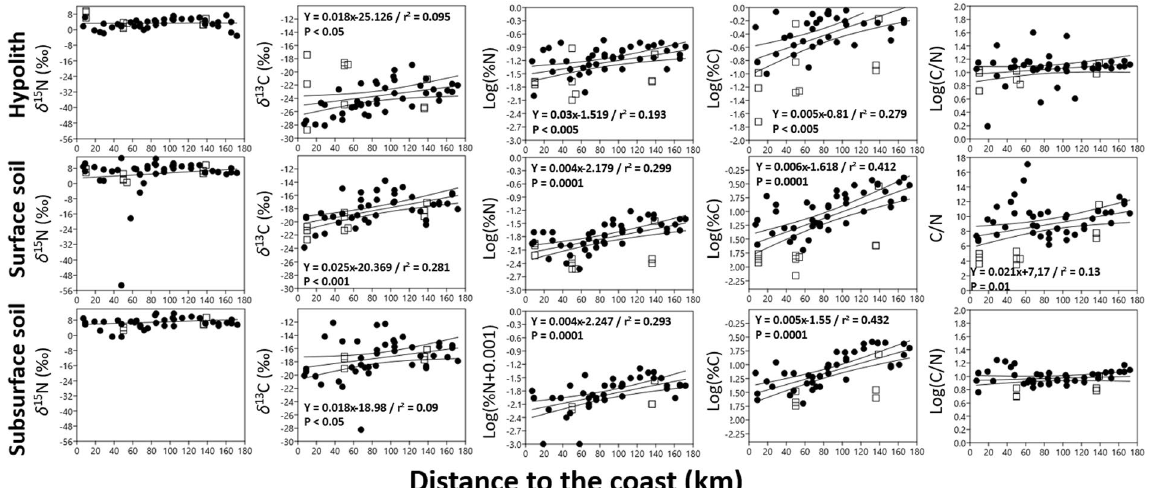
Figure 4. Spatial relationships between Namib Desert hypolithic and edaphic C and N chemistries with the distance to the coast. When significant (p < 0.05) relationships are indicated in the plot along with OLS regression equations and r 2 values. Bootstrapped 95 percent confidence intervals (1999 replicates) border the regression line. □ Dune; ● Gravel